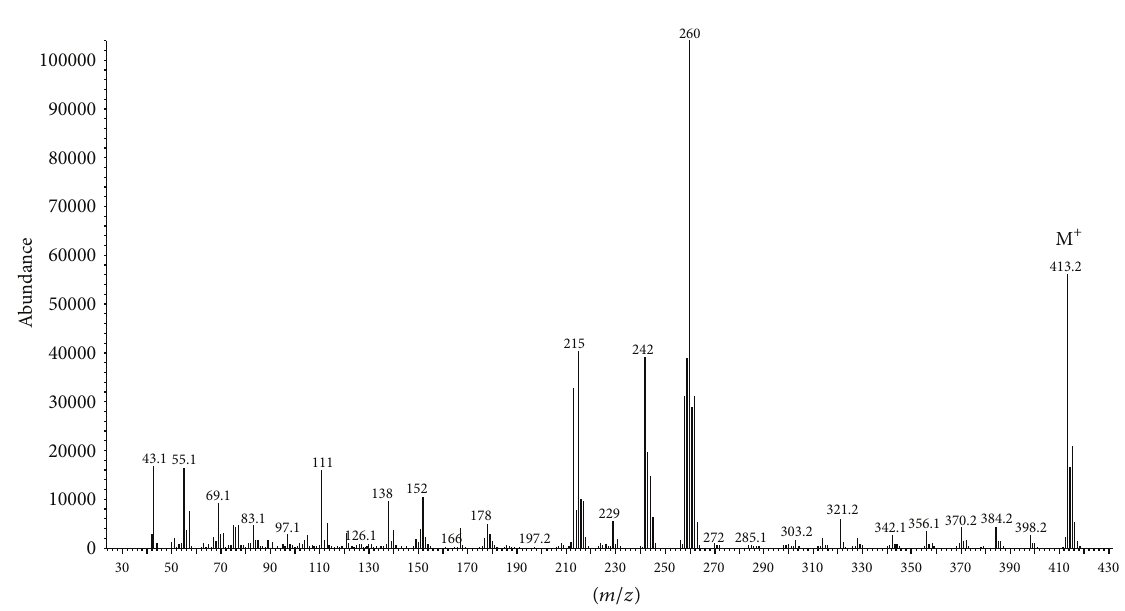
Figure 1: EI mass spectrum of undecyl 4- { [(4-chlorophenyl)imino]methyl } benzoate showing molecular ion peak (M + ).